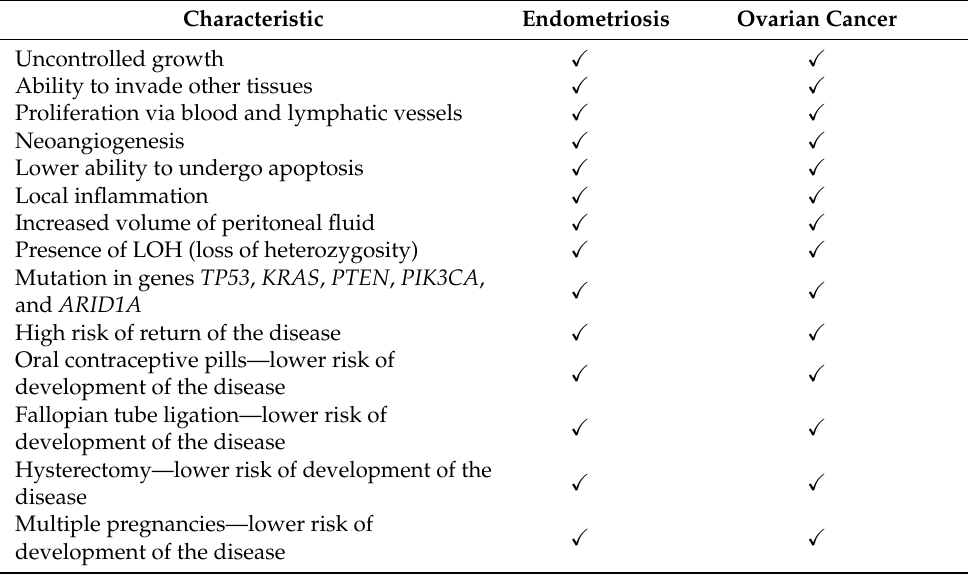
Table 1. Similar features of endometriosis and ovarian cancer [2,5,75–79]. Characteristic Endometriosis Ovarian